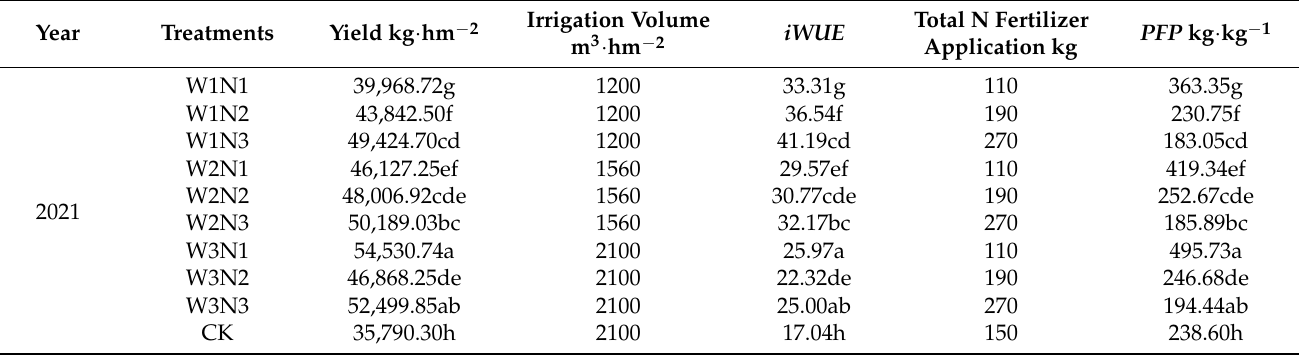
Table 2. Effects of water and nitrogen regulation on irrigation water use efficiency and nitrogen fertilizer bias productivity.